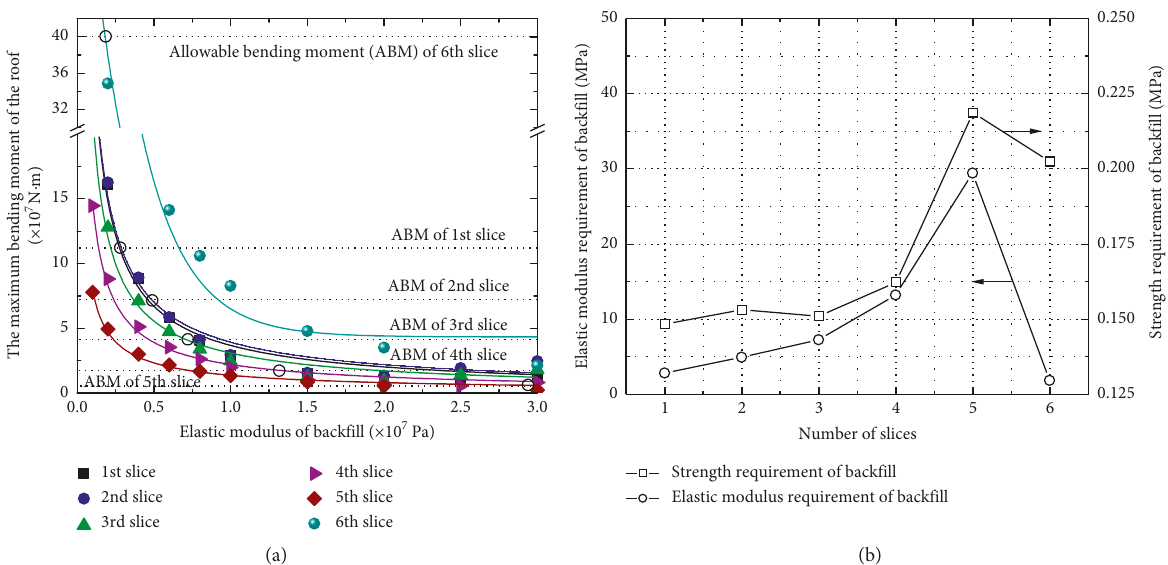
Figure 10: The performance requirement of cemented backfill: (a) the elastic modulus of backfill versus the maximum bending moment of the roof; (b) the elastic modulus and strength requirement of backfill for different